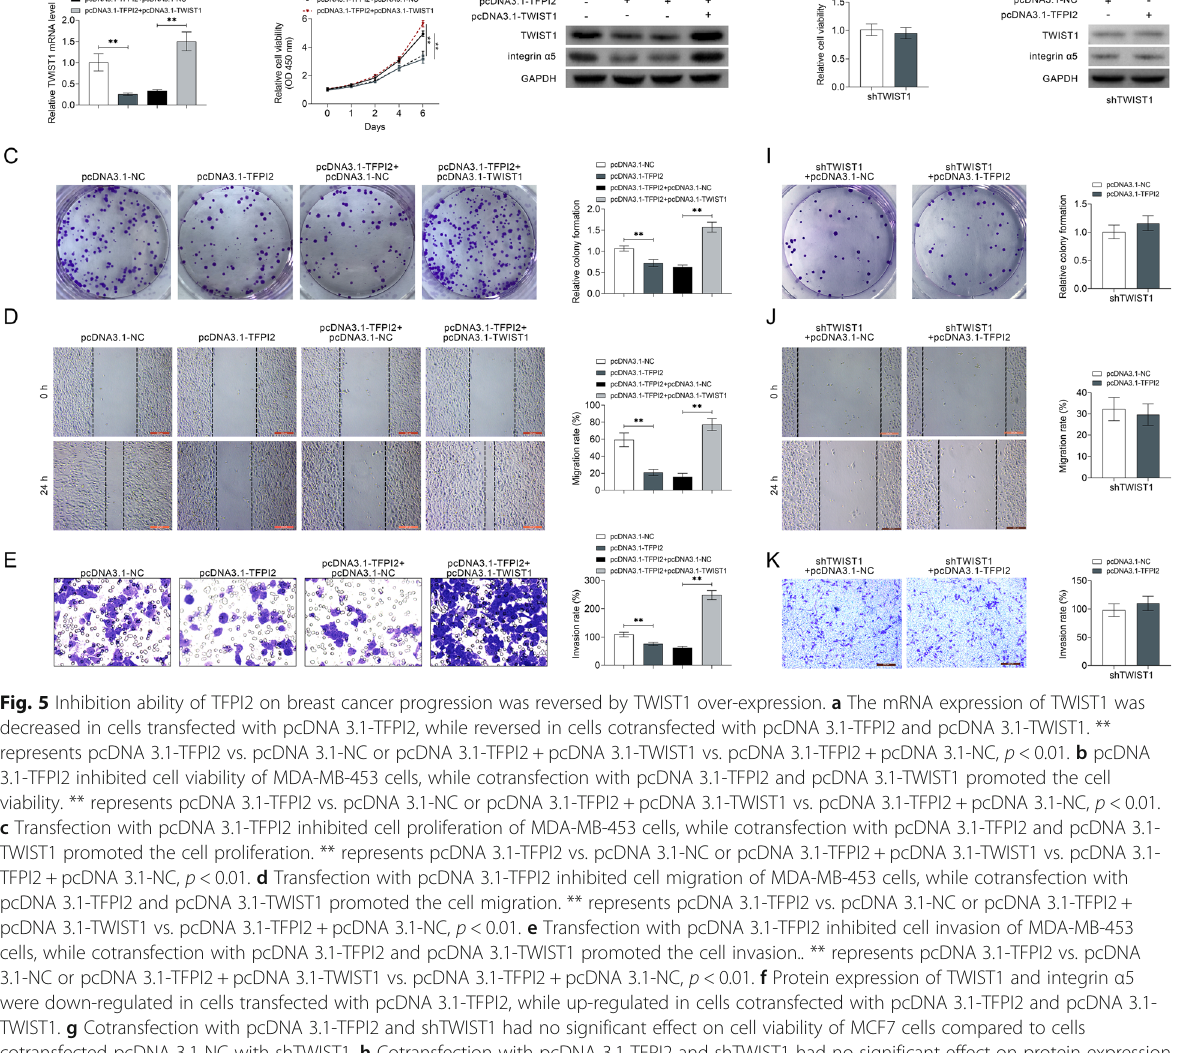
TWIST1 protein expression by TFPI2 over-expression was also reversed by additional over-expression of TWIST1 (Fig. 5f). Moreover, MCF7 cells were also cotransfected with pcDNA 3.1-TFPI2 and shTWIST1. However, cotransfection with pcDNA 3.1-TFPI2 and shTWIST1 had no significant effect on cell viability (Fig. 5g), protein expression of TWIST1 and integrin α 5 (Fig. 5h), cell proliferation (Fig. 5i), cell migration (Fig. 5j) and invasion (Fig. 5k) compared to cells cotransfected pcDNA 3.1-NC with shTWIST1.